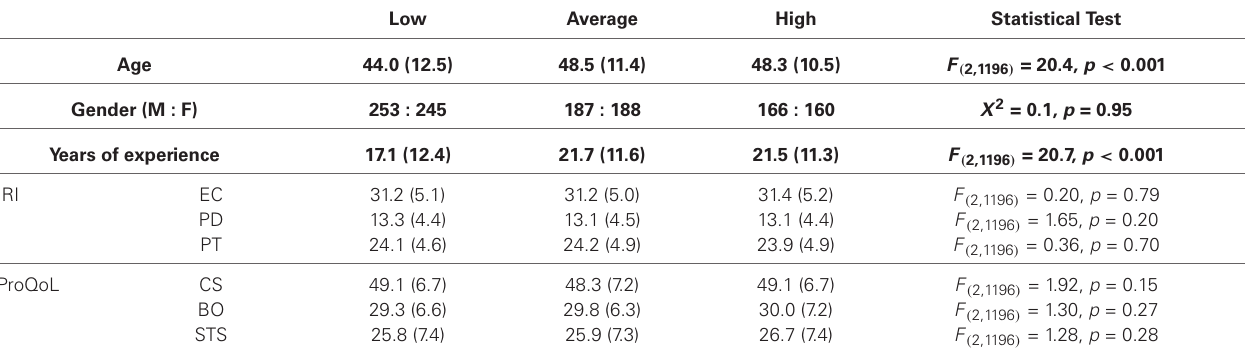
Table 2 | Comparison of demographic, IRI and ProQoL variables between participants group based on their type of specialty .